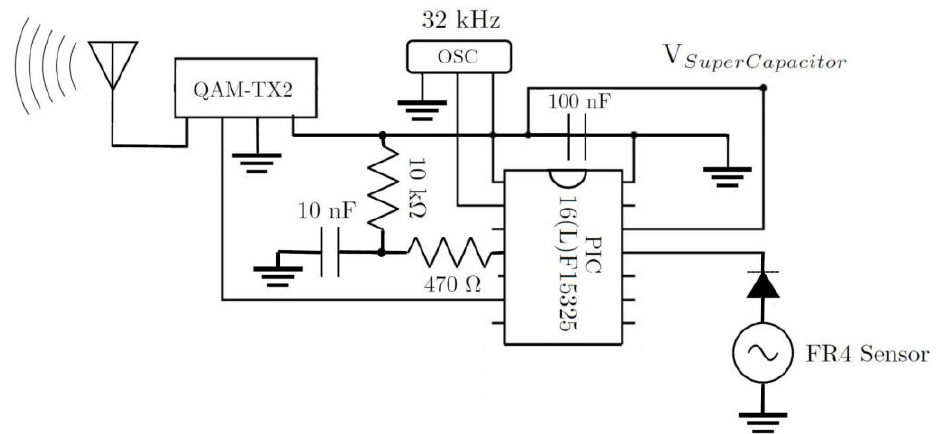
Figure 9. Circuit diagram and interconnections of the microcontroller transmitter subsystem com- ponents used in the wireless vibration sensor system presented in this